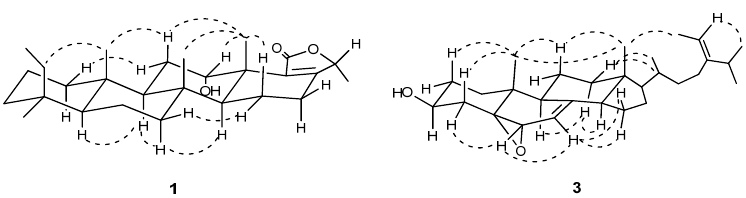
Figure 3. Key ROESY correlations of 1 and 3 .